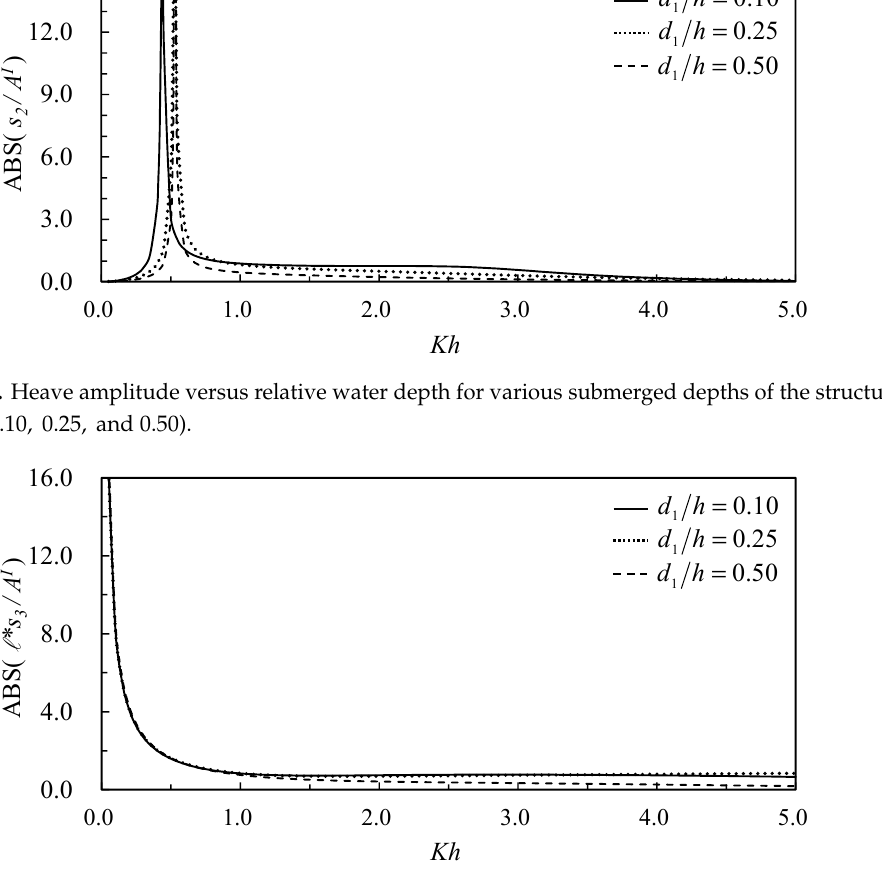
Figure 17. Pitch amplitude versus relative water depth for various submerged depths of the structure ( 𝑑 (cid:2869) / ℎ = 0.10, 0.25, and 0.50 ).